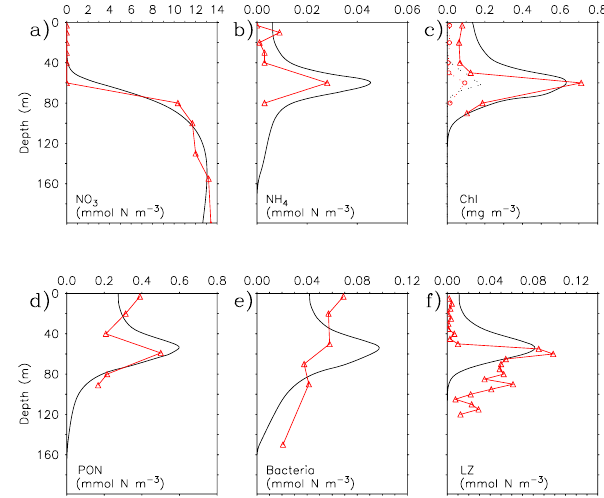
Fig. 7. Model–data comparisons (scalars) for the “no photoammoni- fication” run. Model outputs are in black and observations in red: (a) NO 3 , (b) NH 4 , (c) Chl for SP and LP (in the model, full and dashed lines, respectively; in observations, triangles and circles, re- spectively), (d) PON (i.e., sum of LP, SP, SZ, BACT and dPON in the model), (e) biomass of bacteria and (f)